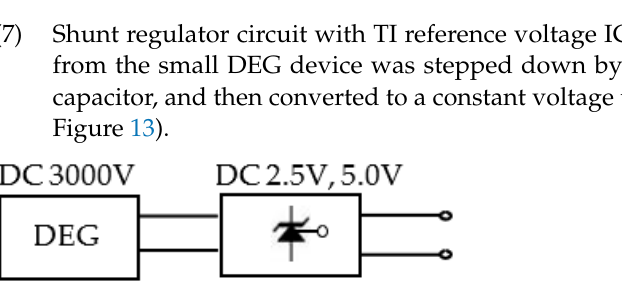
Figure 12. Shunt regulator circuit with TI reference voltage IC (5 V output).